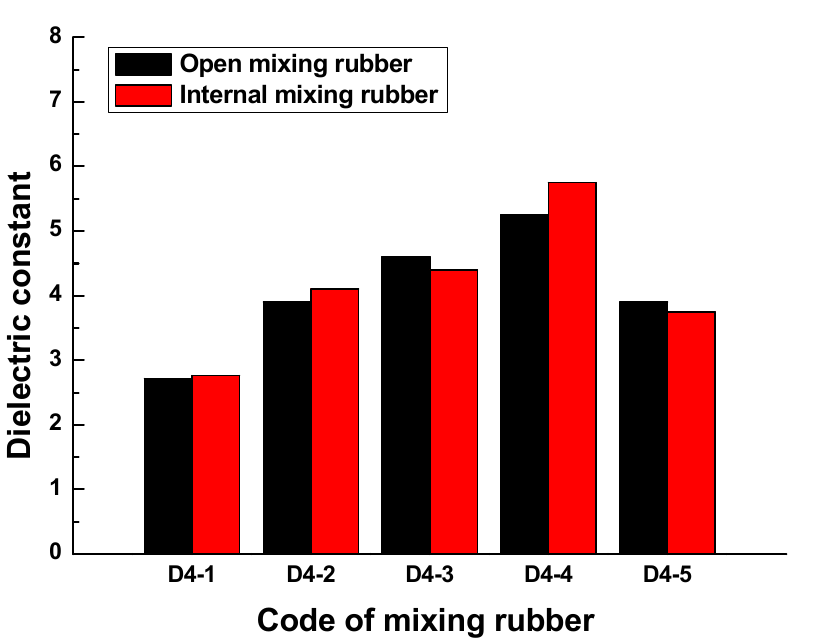
Figure 8. The maximum dielectric constants of the rubber samples obtained by different mixing processes. Table 6. The codes for the rubber compounds containing